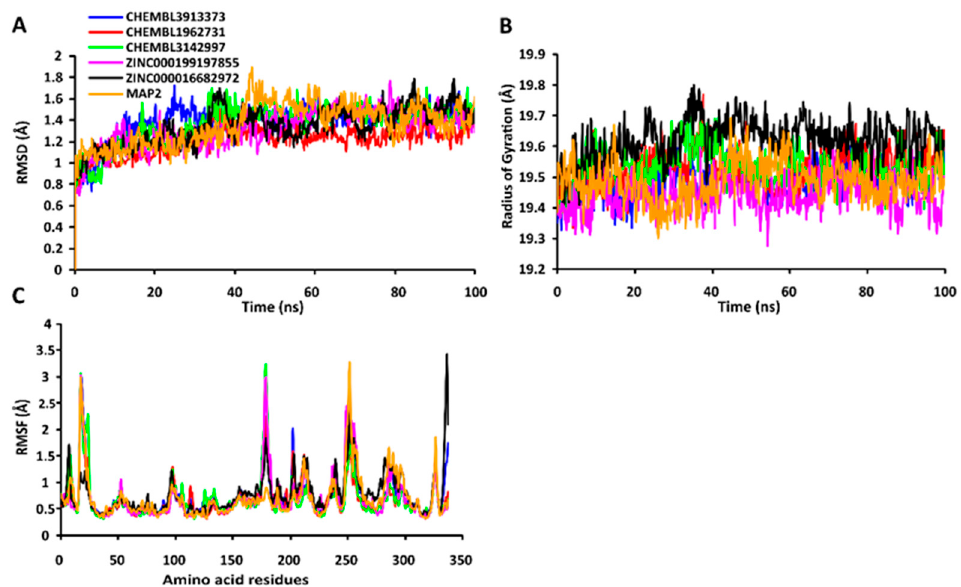
Figure 7. Stabilities of the protein–ligand complexes during 100 ns MD simulations. ( A ) RMSD values of the protein–ligand complexes fitted to the C α backbone of MetAP. The x -axis represents the duration of simulation, while the y -axis depicts the RMSD. ( B ) Analysis of the Rgvalues of the protein–ligand complexes. The x -axis represents the duration of simulation, while the y -axis depicts the deviations in Rg. ( C ) RMSF values of the C α backbone of MetAP. The x -axis depicts the total number of residues, while the y -axis represents the RMSF in Å. The different ligands complexed with MetAP are indicated by lines of different colors.